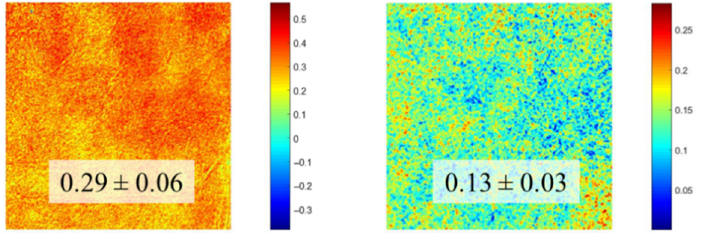
Figure 9. SHG intensity values for the SHG images of the precedent figure (blue, upper panels; green, bottom panels).